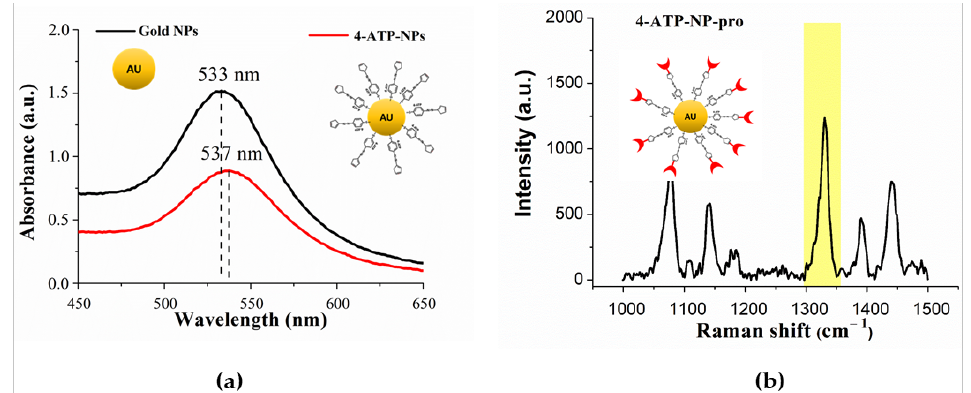
Figure 4. ( a ) Absorption spectrum of NPs before (black line) and after (red line) conjugation with 4-ATP. The maximum absorption peaks are marked by dashed lines. ( b ) Raman spectrum of the probe (4-ATP-NP-pro), sketched in the inset (not in scale), charged with a protein (here antip53). The yellow band highlights the Raman marker peaked at 1328 cm −1 .